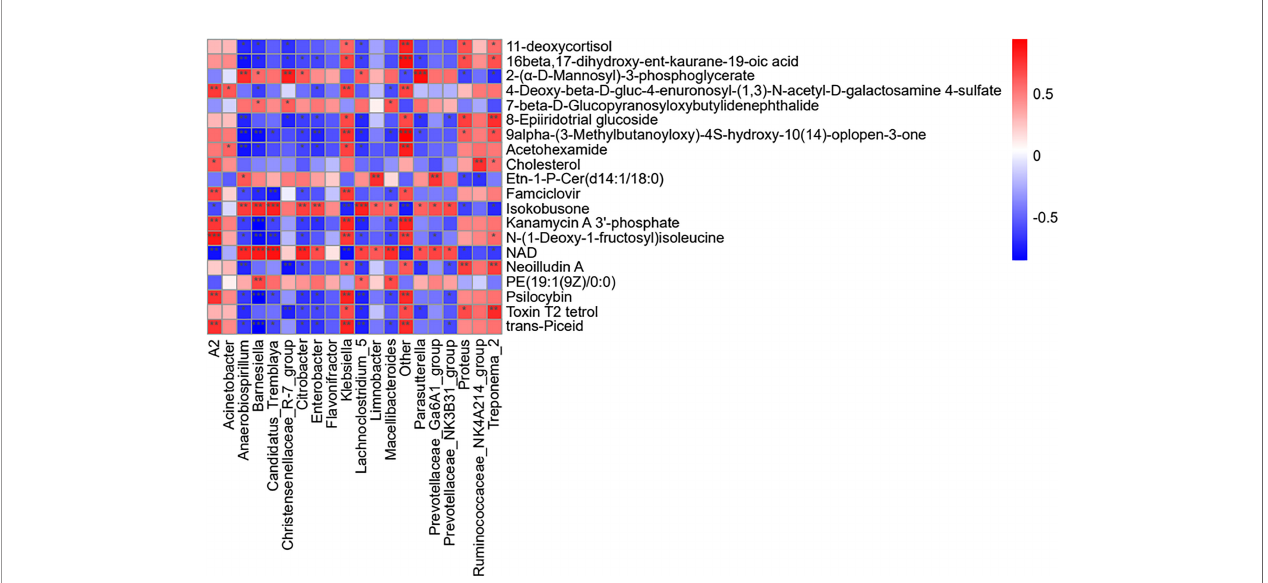
FIGURE 8 | Analysis of the effects of LPS on the microbial genus and metabolite concentration. For each species with distinct behaviors and the corresponding metabolites in each column, the orange color indicates a positive correlation, while blue indicates a negative correlation. The darker the color, the greater is the correlation. The closer the color is to white, the closer is the correlation to zero. ***p < 0.001, **p < 0.01, and *p < 0.05 (i.e., signi fi cance of